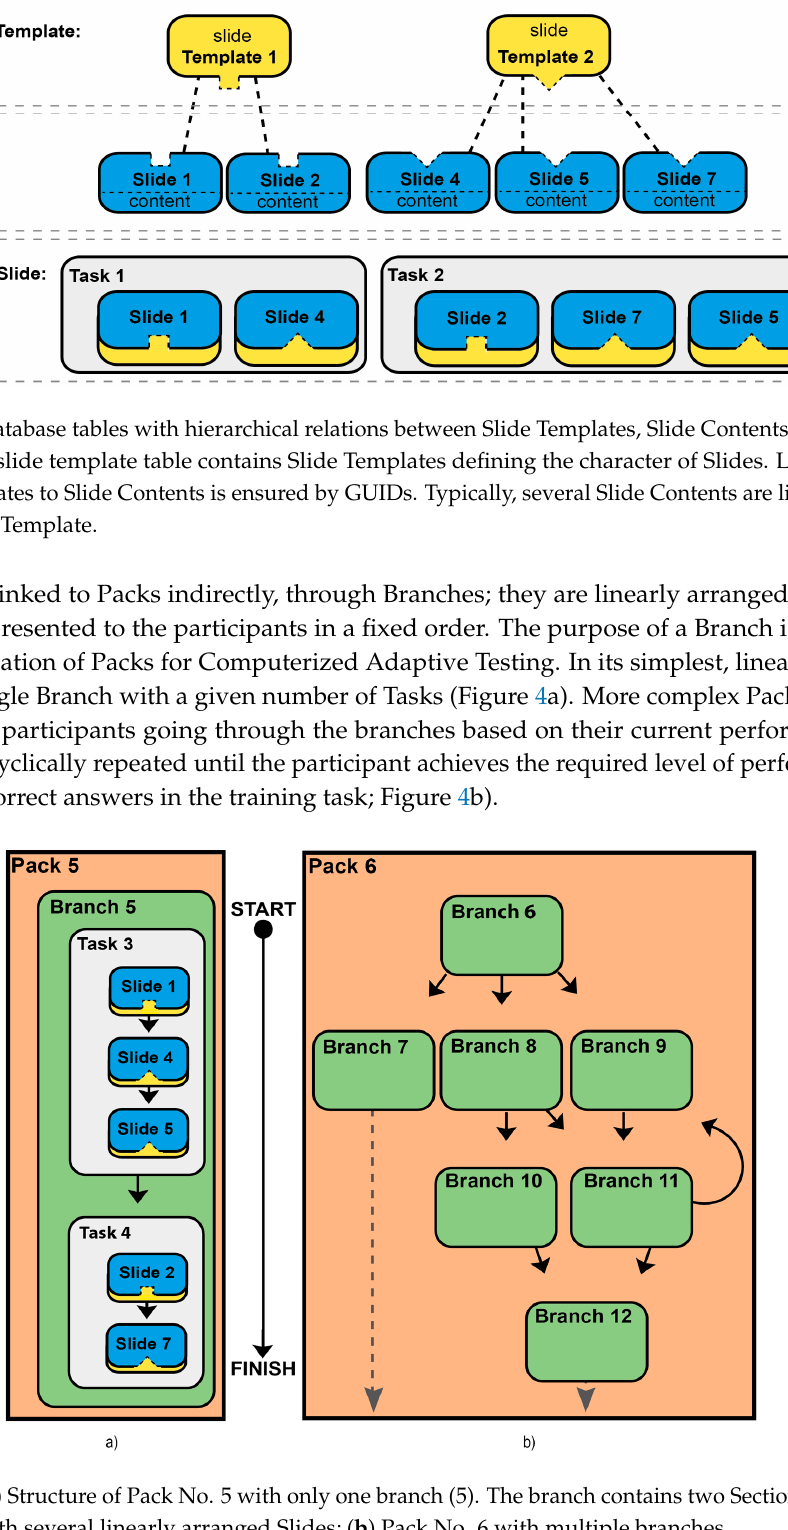
Figure 4. ( a ) Structure of Pack No. 5 with only one branch (5). The branch contains two Sections (Tasks) (3 and 4) with several linearly arranged Slides; ( b ) Pack No. 6 with multiple branches.